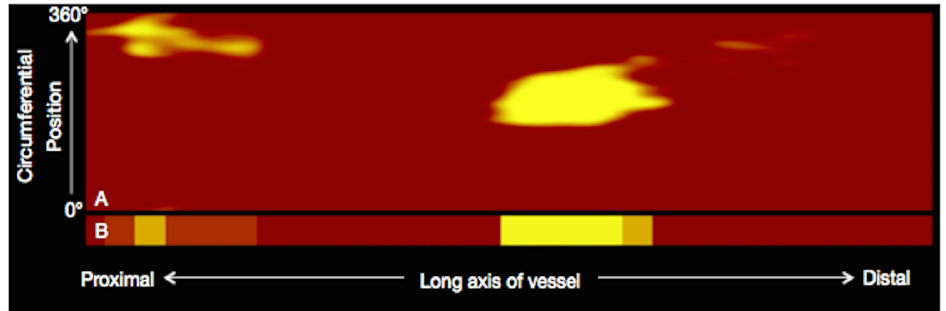
Figure 6. Illustration of the NIRS chemogram and block chemogram. The x-axis of the chemogram represents the spatial location along the long axis of the vessel. The y-axis of the chemogram represents circumferential position. Red and yellow regions correspond to coronary segments with, respectively, a low and high probability of LRP. Reused with permission from AME Publishing Company [80].